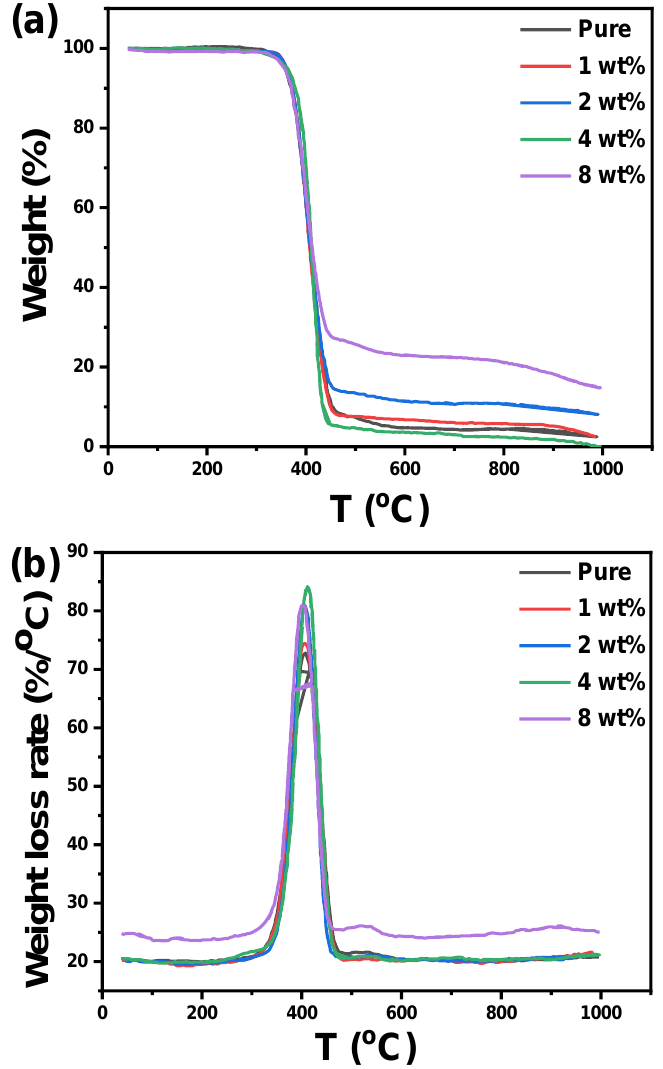
Figure 8. ( a ) TGA and ( b ) DTG curves for pure acrylic polymer and acrylic polymer/cement nanocomposites.